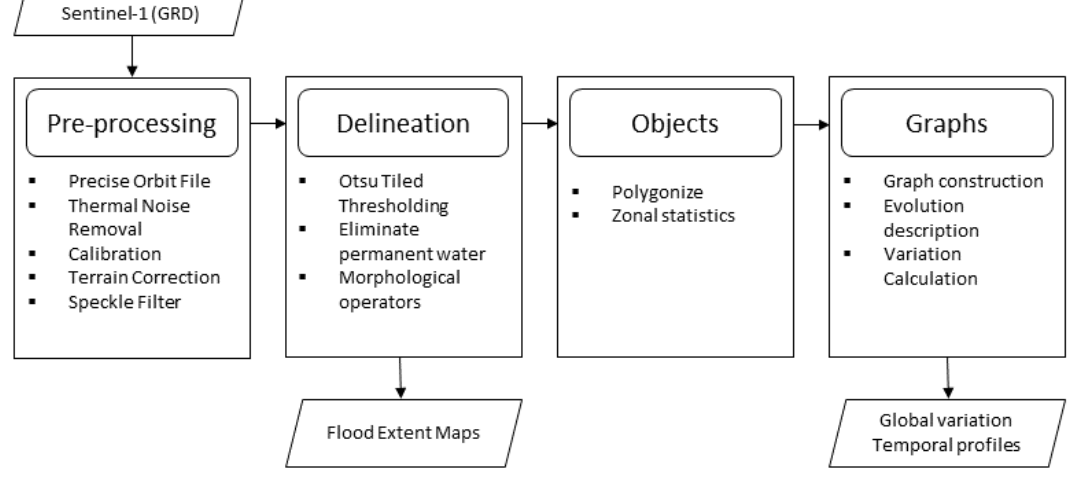
Figure 3. The framework with